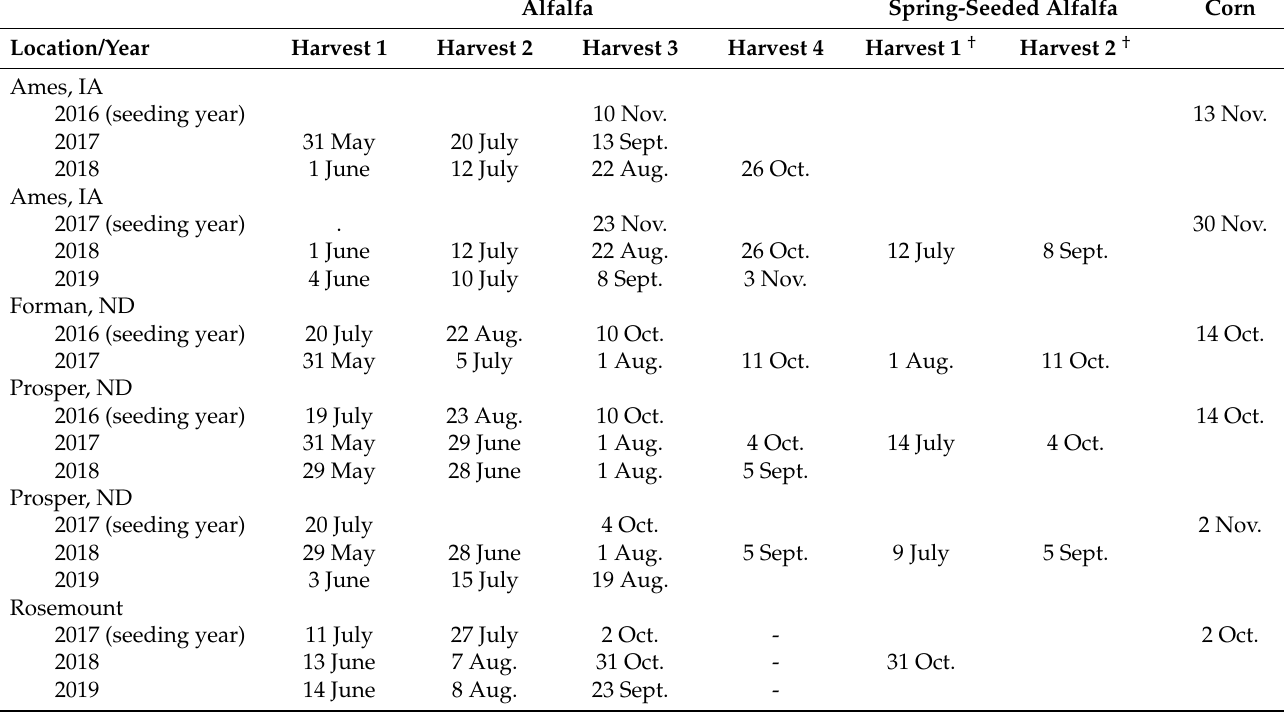
Table 3. Harvest dates of alfalfa and corn at all locations and years. Alfalfa Spring-Seeded Alfalfa